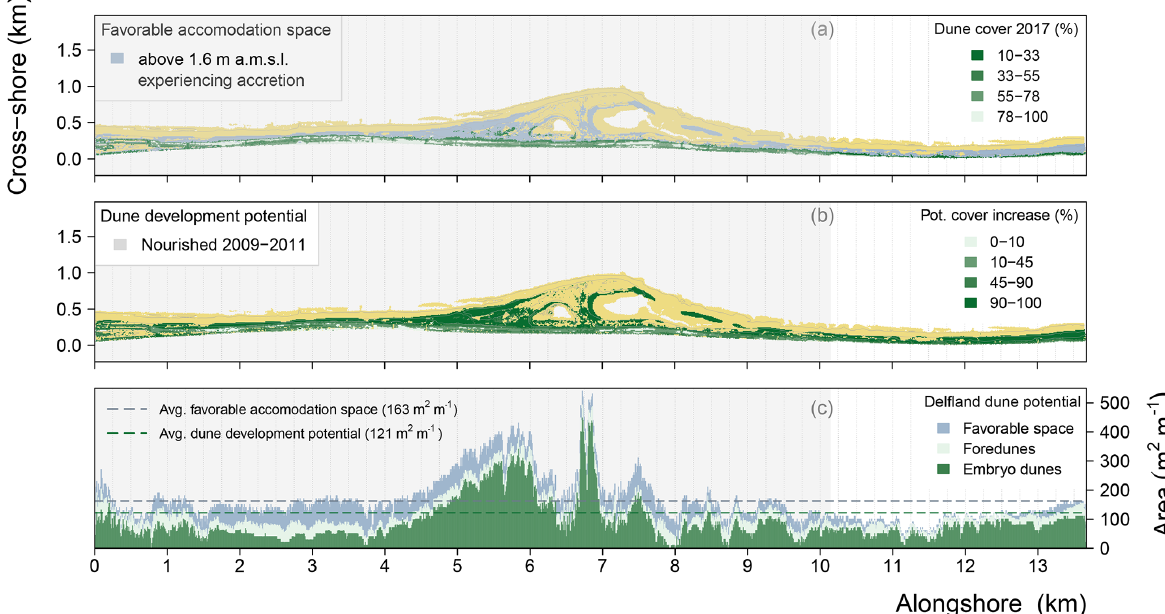
Figure 6. Favorable accommodation space to indicate dune development potential along the Delfland coast. (a) Map of dune cover (%) by marram grass in 2017 and accommodation space favorable for dune development: located above 1.6ma.m.s.l. and experiencing an accretion of sand. (b) Map indicating Delfland coast dune development potential, calculated as the potential of marram grass to increase in cover (%) based on the accommodation space favorable for dune development and taking into account the dune cover already present in 2017. (c) Alongshore variation of favorable accommodation space and potential for dune development along the Delfland coast (m 2 m − 1 ), differentiated for foredunes and embryo dunes.